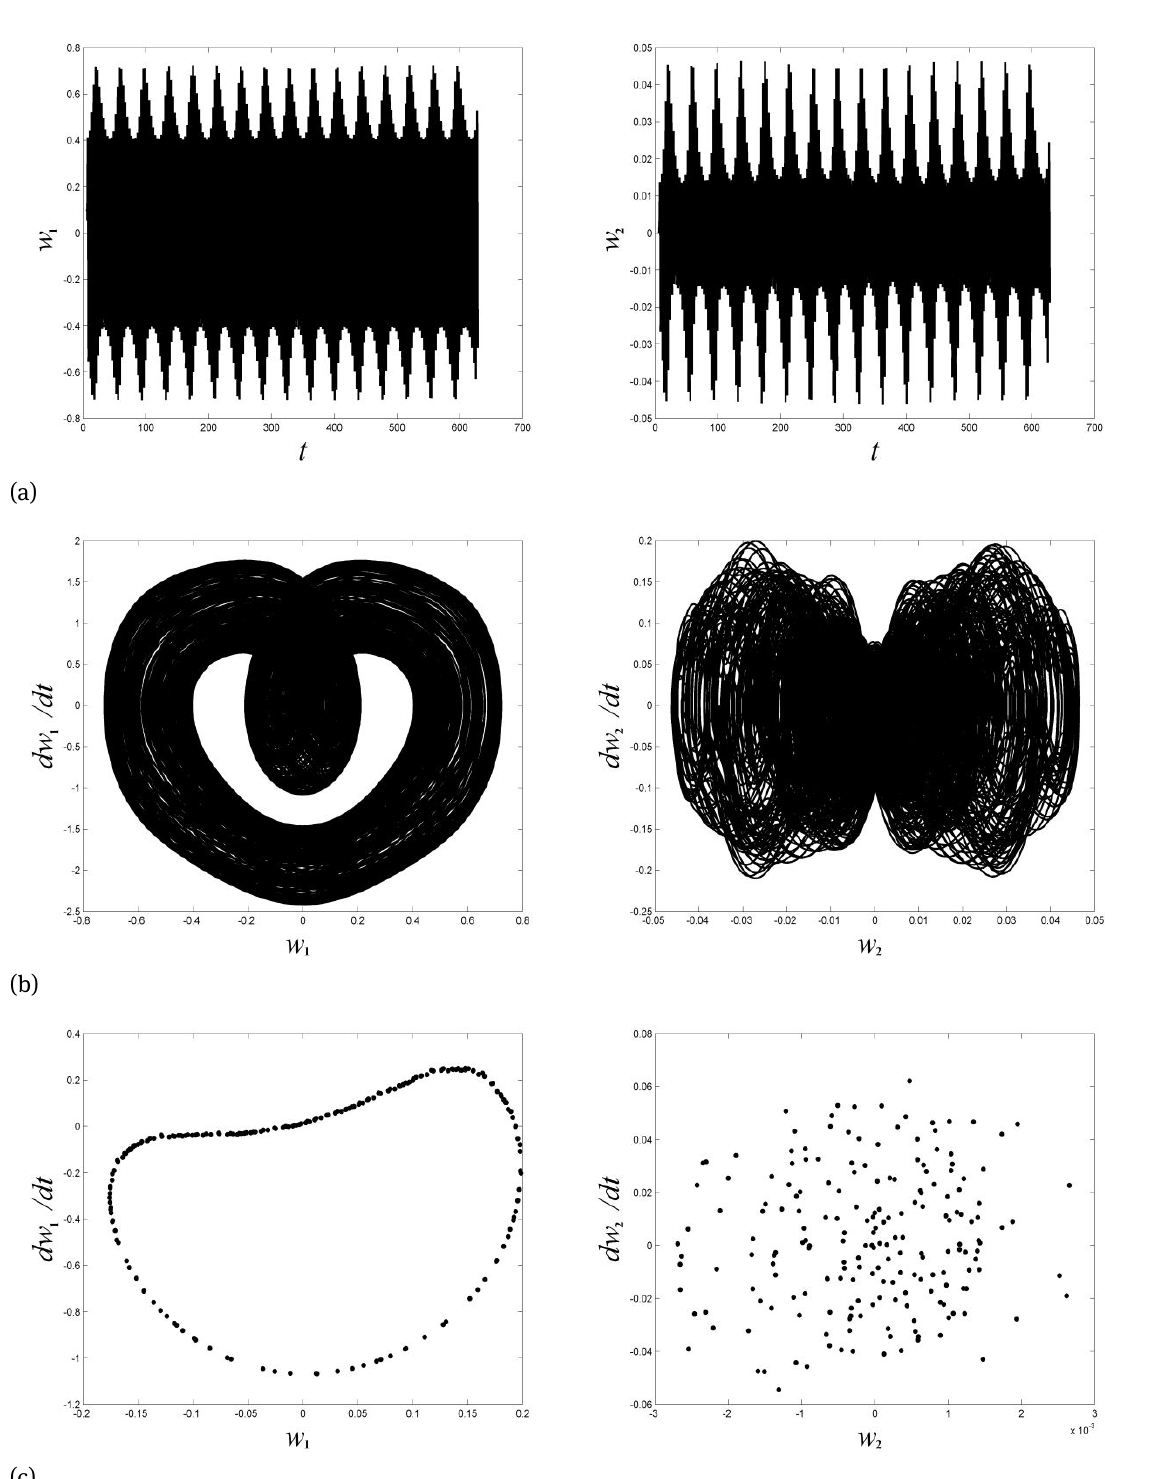
Fig. 5. Quasiperiodic and chaotic behaviors of the cantilever beam system shown in wave diagrams (a), phase diagrams (b) and Poincaré maps (c). q = 1000sin(20 πt )( Pa ) and e c = 8.28 × e 9 (cid:0) N / Nm 2 (cid:1)